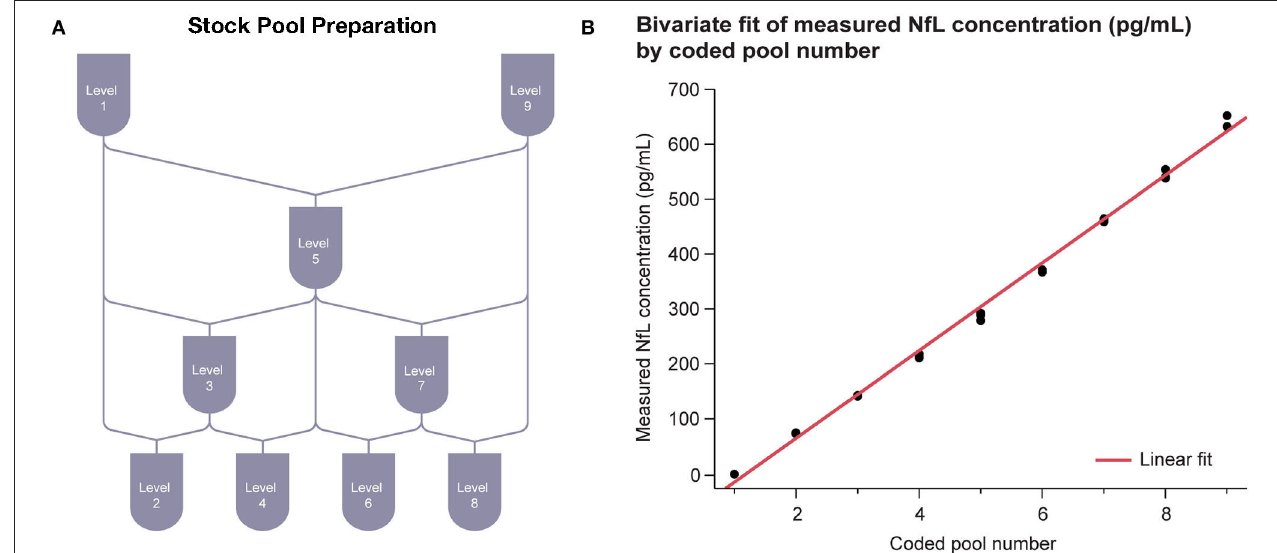
FIGURE 3 | Serum linearity. (A) Sample stock pools with high (serum spiked with recombinant NfL to above ULoQ) and low (NfL-depleted serum below LLoQ) levels of NfL were used to prepare nine concentration levels evenly spaced across the assay range. (B) Regression between measured concentration and coded pool number was performed. LLoQ, lower limit of quantitation; NfL, neurofilament light chain; ULoQ, upper limit of quantitation.